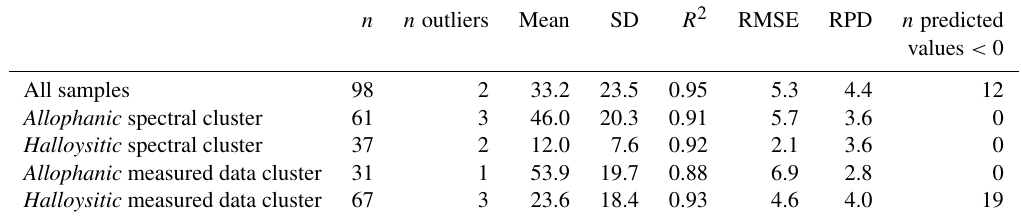
Table 3. Cross-validation statistics of modified partial least-squares regression for the models of prediction by MIRS of soil organic carbon contents (gCkg − 1 soil) after calibration on all of the soil samples (All) or on two clusters defined by their MIRS spectra, or by their conventionally measured data (Al o , Al p , Si o , Fe o , Al o + 0 . 5Fe o , allophane, (Al o − Al p ) / Si o ).